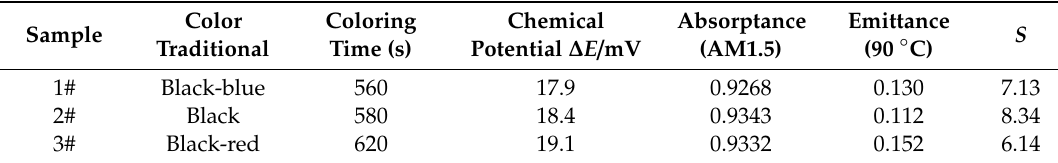
Table 1. The relationship of the potential di ff erence and the color.